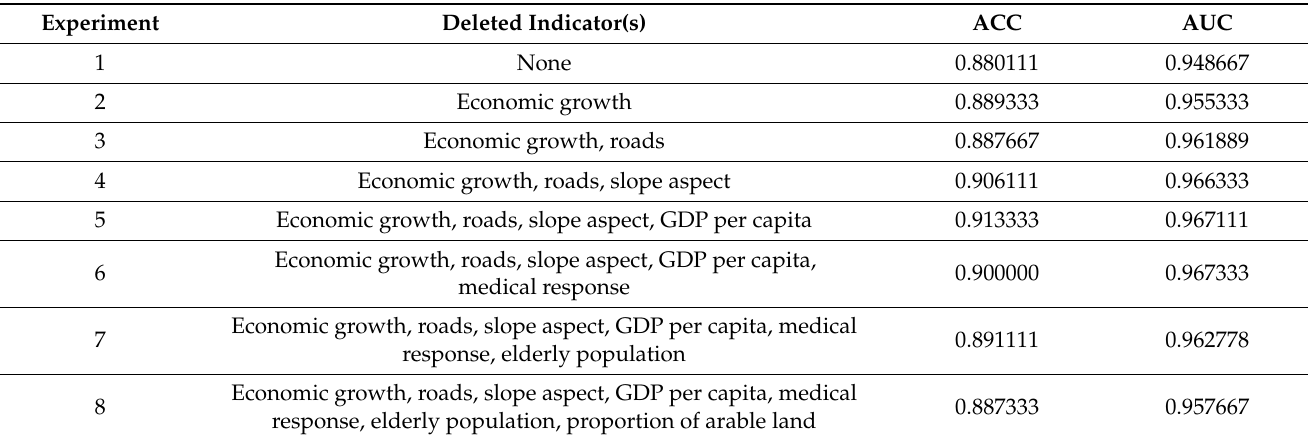
Table 2. Experimental process record